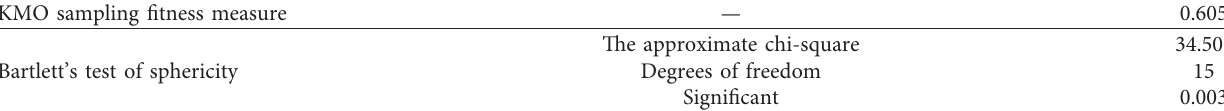
Table 4: KMO and Bartlett’s test of